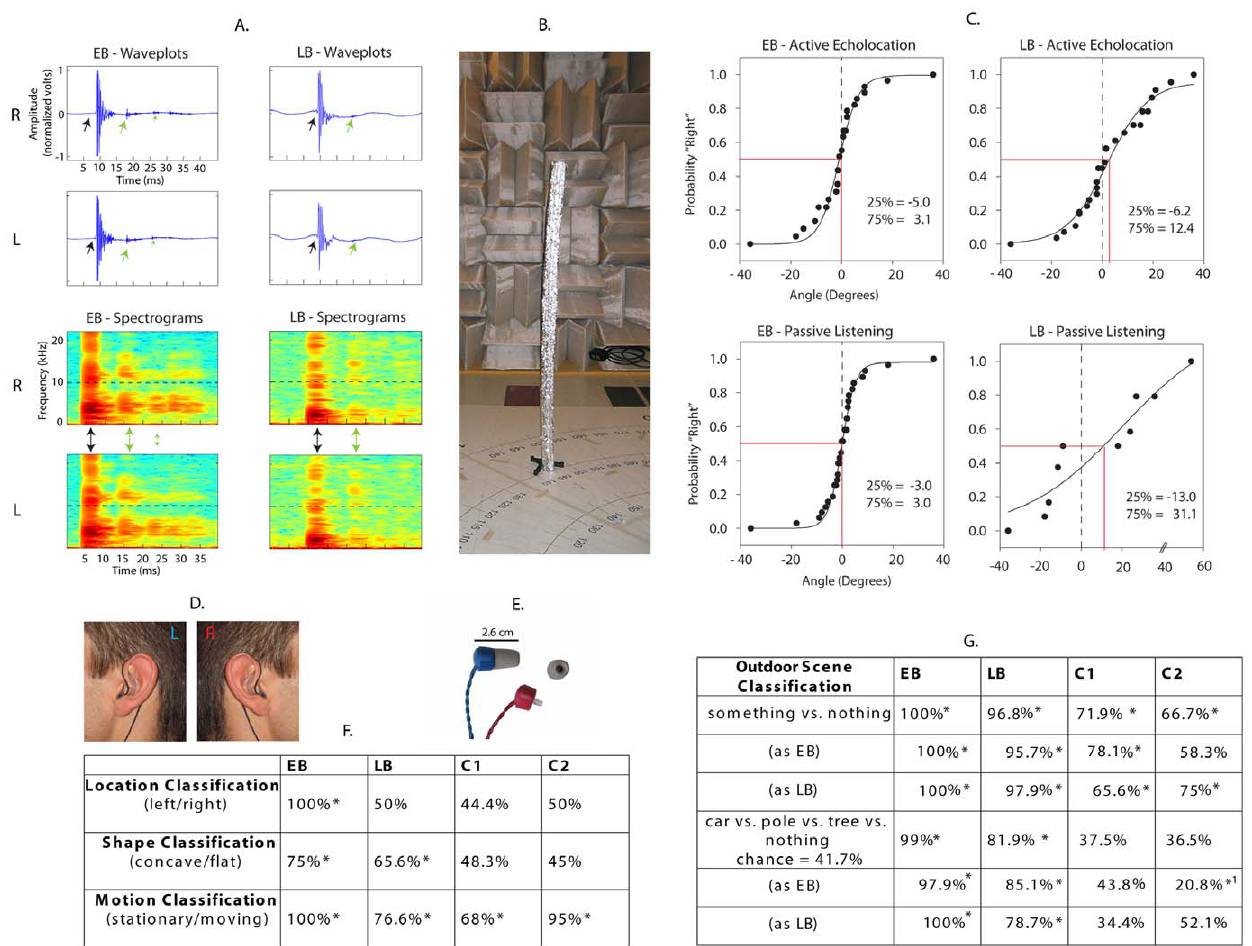
Figure 1. Illustration of click sounds, click echoes and experimental materials, and summary of behavioural results. A: Waveplots and spectrograms of the sound of a click (highlighted with black arrows) and its echo (highlighted with green arrows) recorded in the left (L) and right (R) ears of EB and LB (sampling rate 44.1 kHz) (Sound S1 and Sound S2). Both EB and LB made the clicks in the presence of a position marker (shown in 1B) located straight ahead. Spectrograms were obtained using an FFT window of 256 samples, corresponding to approximately 5.6 ms in our recordings. Waveform plots and spectrograms are for illustration. While the exact properties of the click and its echo (e.g. loudness, timbre) are specific to the person generating the click as well as the sound reflecting surface, prominent characteristics of clicks are short duration (approximately 10 ms) and broad frequency spectra, both of which are evident in the plots. B: Position marker used for angular position discrimination experiments during active echolocation, and to make recordings for the passive listening paradigm. The marker was an aluminium foil covered foam half-tube (diameter 6 cm, height 180 cm), placed vertically, at a distance of 150 cm, with the concave side facing the subject. Note the 125-Hz cutoff wedge system on the walls of the anechoic chamber. C: Results of angular position discrimination experiments (for examples of sound stimuli used during passive listening listen to Sounds S5 and S6). Plotted on the ordinate is the probability that the participant judges the position marker to be located to the right of its straight ahead reference position. Plotted on the abscissa is the position of the test position with respect to the straight ahead in degrees. Negative numbers indicate a position shift in the counter clockwise direction. Psychometric functions were obtained by fitting a 3- parameter sigmoid to the data. 25% and 75% thresholds and bias (denoted in red) were estimated from fitted curves. The zero-bias line (dashed line) is drawn for comparison. D: Stimuli were recorded with microphones placed in the echolocator’s ears, directly in front of the ear canal. E: During passive listening, stimuli were delivered using fMRI compatible in-ear headphones, which imposed a 10 kHz cutoff (marked with a dashed line in spectrograms in A). F–G: Behavioral results from the various passive-listening classification tasks (for examples of sound stimuli used during the various classification tasks listen to Sound S7, Sound S8, Sound S9, Sound S10, Sound S11, Sound S12, Sound S13). Shown is percentage correct. Asterisks indicate that performance is significantly different from chance (p , .05). Unless otherwise indicated, chance performance is 50%. Sample sizes (reported in Table S1 and Table S2) fulfil minimum requirement for confidence intervals for a proportion based on the normal approximation [48]. 1 = less than chance, because of bias to classify as ‘tree’. doi:10.1371/journal.pone.0020162.g001 time of testing) lost vision at age 14 years due to optic nerve auditory stimuli that allowed us to identify those brain areas that responded only to the echoes within a train of echolocation atrophy (late onset blindness). Both were right-handed, had sounds. normal hearing and normal auditory source localization abilities (Figure S1; Audiology Report S1; for samples of sounds used Two blind skilled echolocators participated in the current study. during source localization listen to Sound S3 and Sound S4). Both Participant EB (43 years at time of testing) had partial vision up to EB and LB use echolocation on a daily basis, enabling them to 13 months of age. At 13 months, his eyes were removed due to retinoblastoma (early onset blindness). Participant LB (27 years at explore cities during travelling and to hike, mountain bike or play